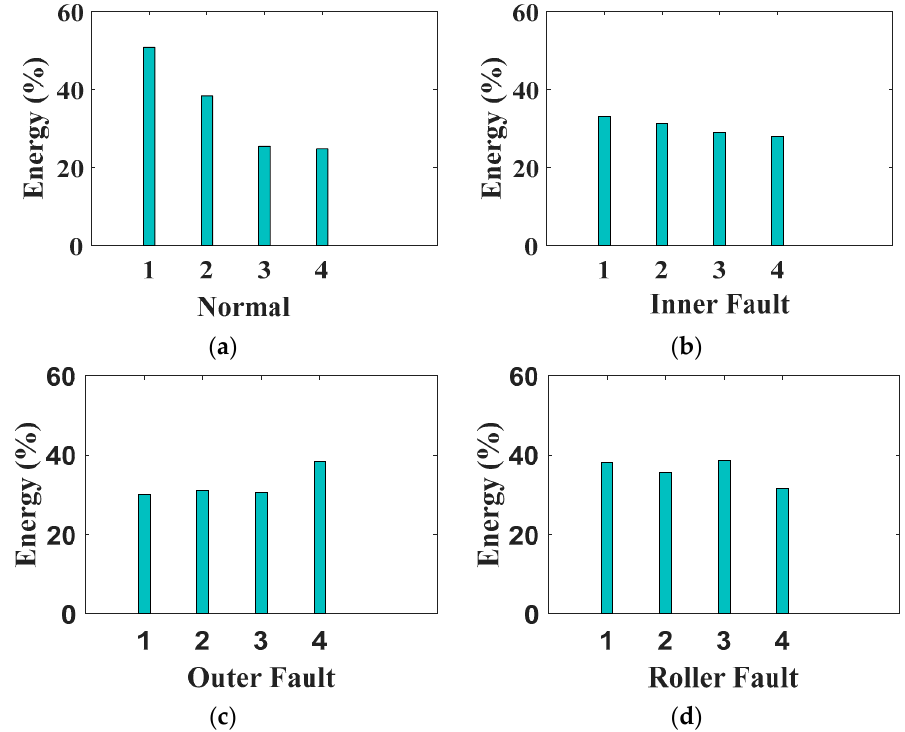
Figure 4. Wavelet energy features, ( a ) baseline condition; ( b ) inner fault signals; ( c ) outer fault signals; and ( d ) roller fault signals.